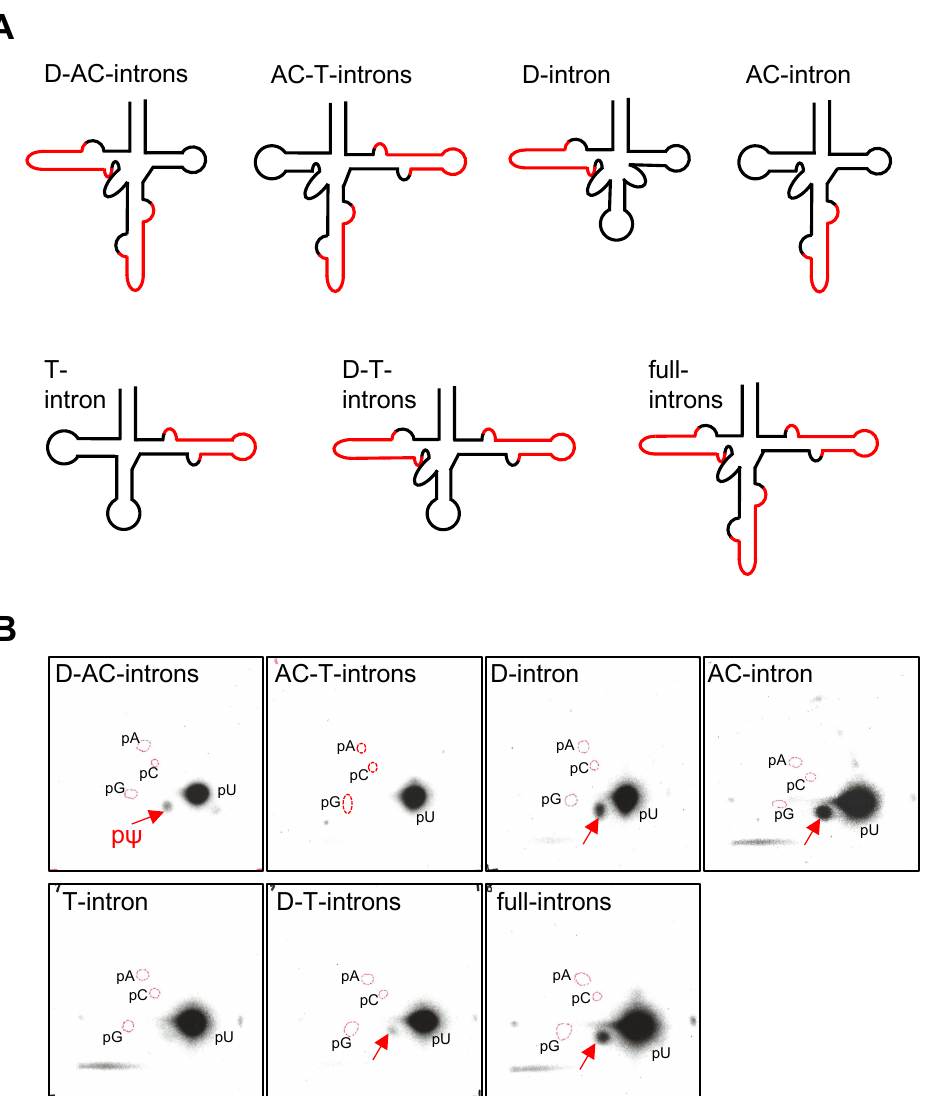
Figure 4. In vitro pseudouridylation activity of cmPus1 towards various pre-tRNA Ile (UAU) tran- scripts forms. ( A ) The secondary structures of pre-tRNAs Ile (UAU) used in the experiments are shown. Intron regions are indicated in red. ( B ) The 32 P-internally labeled pre-tRNA Ile (UAU) variants were incubated with cmPus1, and Ψ formations analyzed by 2D-TLC. Spots derived from p Ψ are indicated by red arrows. A p Ψ spot was detected in pre-tRNA Ile (UAU) containing D-AC-, D-, AC-, D-T-, or